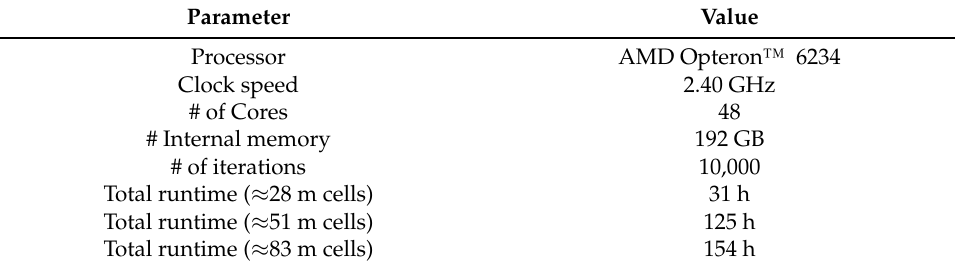
Table 7. OpenFOAM simulation system specifics and